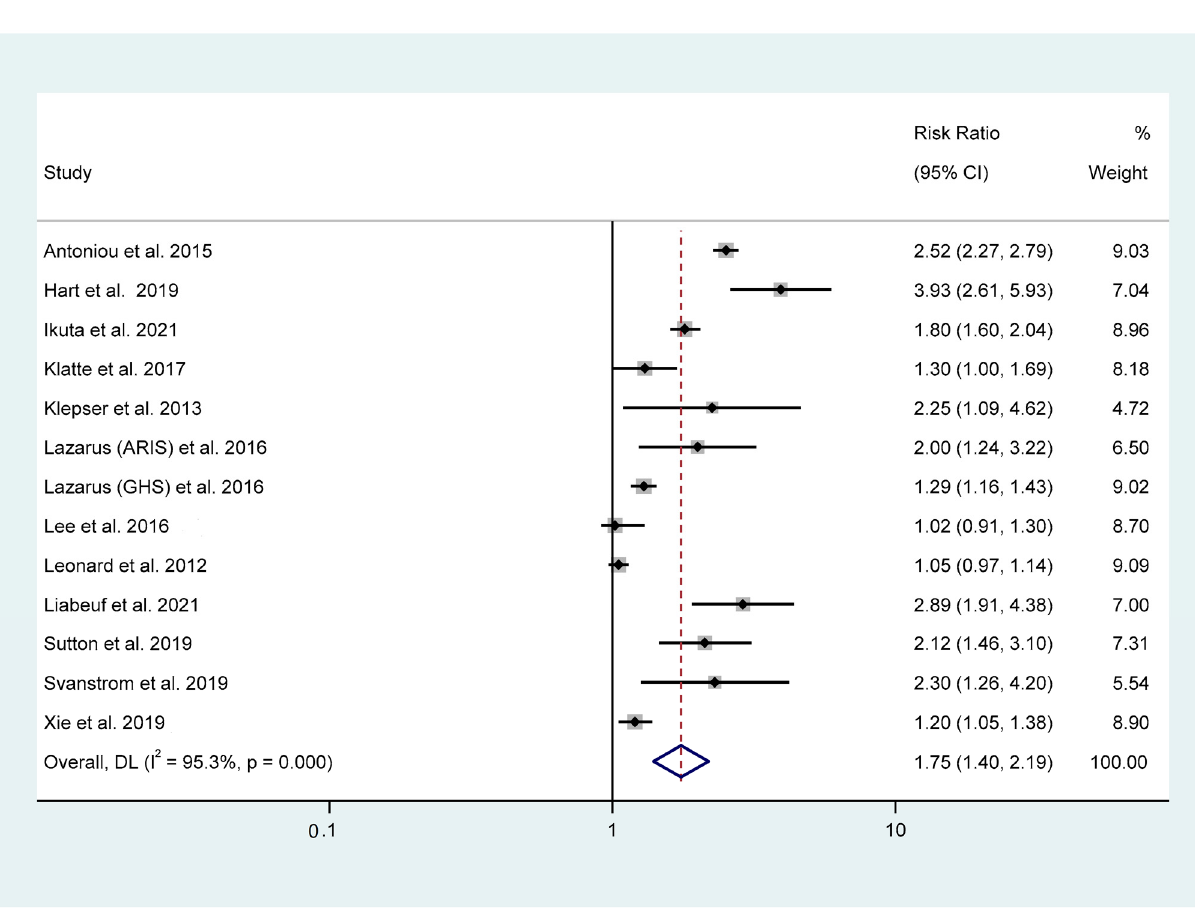
Figure 2. Association between PPI use and the risk of acute kidney injury [13,21–24,32–38].